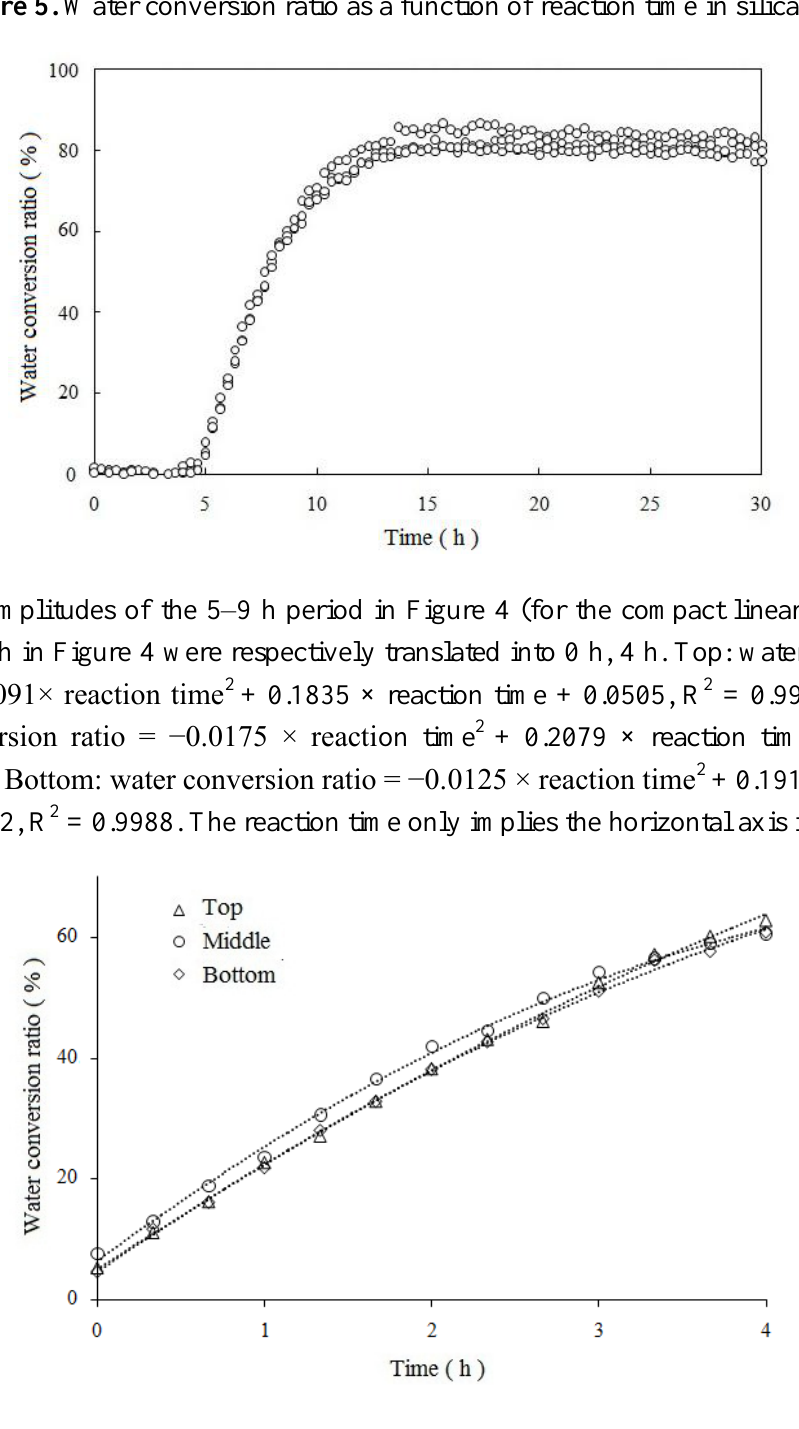
Figure 5. Water conversion ratio as a function of reaction time in silica gel.